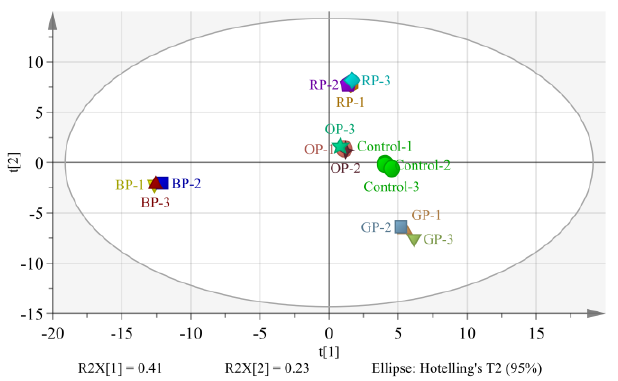
Figure 6. Correlation between volatile compounds and antioxidative abilities of spices. (*** = 0.001 level).